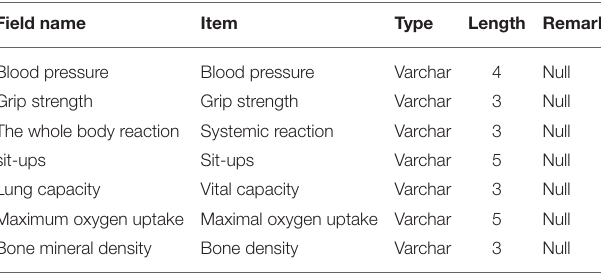
TABLE 3 | Structure on fitness assessment data.